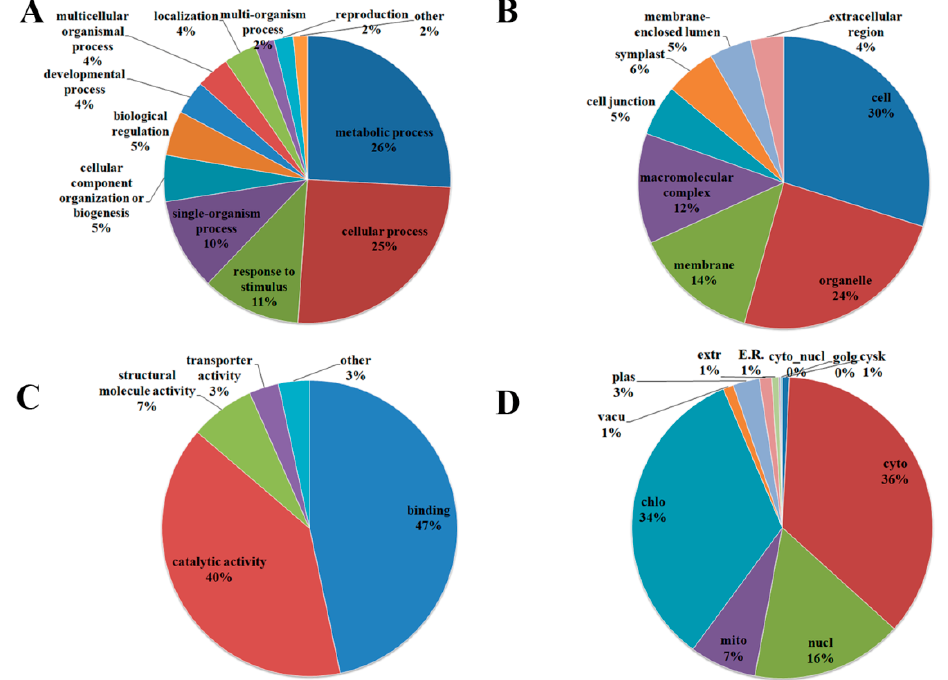
Figure 4. GO analysis of differentially-acetylated proteins in terms of: biological process ( A ); molecular function ( B ); cellular component ( C ); subcellular location ( D ); and acetylation intensity, respectively. The abbreviations in ( D ) represent the following. E.R.: endoplasmic reticulum; extr: extracellular matrix; cyto: cytoplasm; mito: mitochondrial; chlo: chloroplast; vacu: vacuole; cysk: cytoplasmic skeleton; cyto nucl: cytoplasm nuclear.